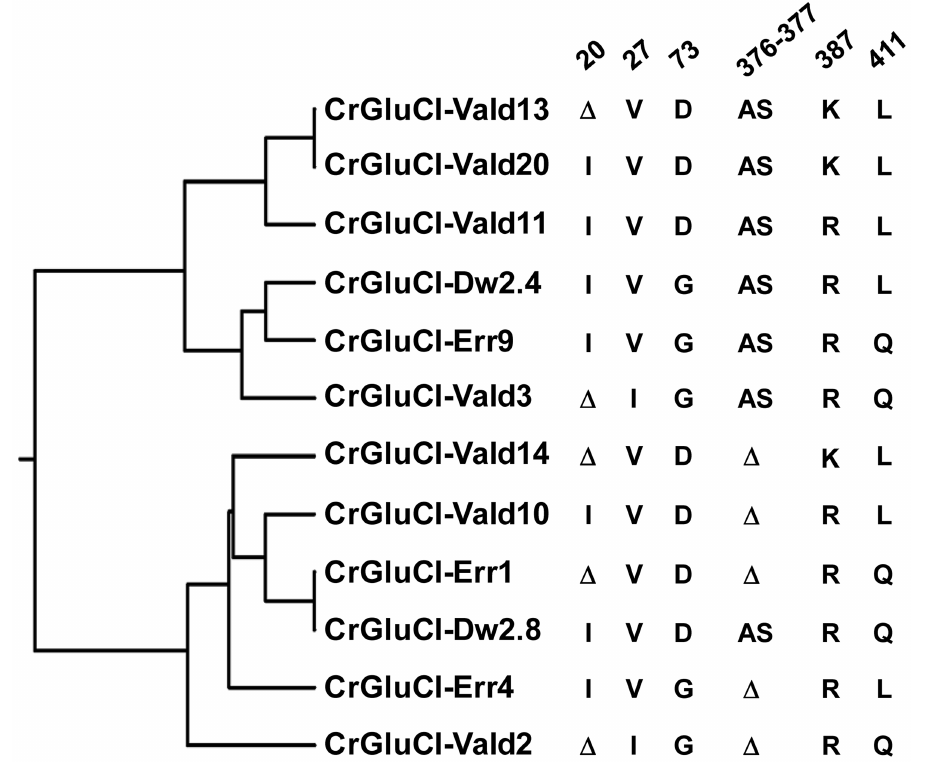
Figure 2. Variations in deduced CrGluCl a primary structure. The rooted phylogenetic tree was done by using the UPGMA method after aligning twelve representative clones with CLUSTALW software (http://www.genome.jp/tools/clustalw). The positions of amino acid changes (V27I, D73G, R387K and L411Q), or deletions (isoleucine 20 (I or D ), and alanine 376 plus serine 377 (AS or D )) are shown. The clone name is composed by CrGluCl a , source and Arabic number. Source: Valdivia (Vald), Darwin (Dw) and Erra´zuriz (Err). Arabic number is the number assigned during the cloning process.